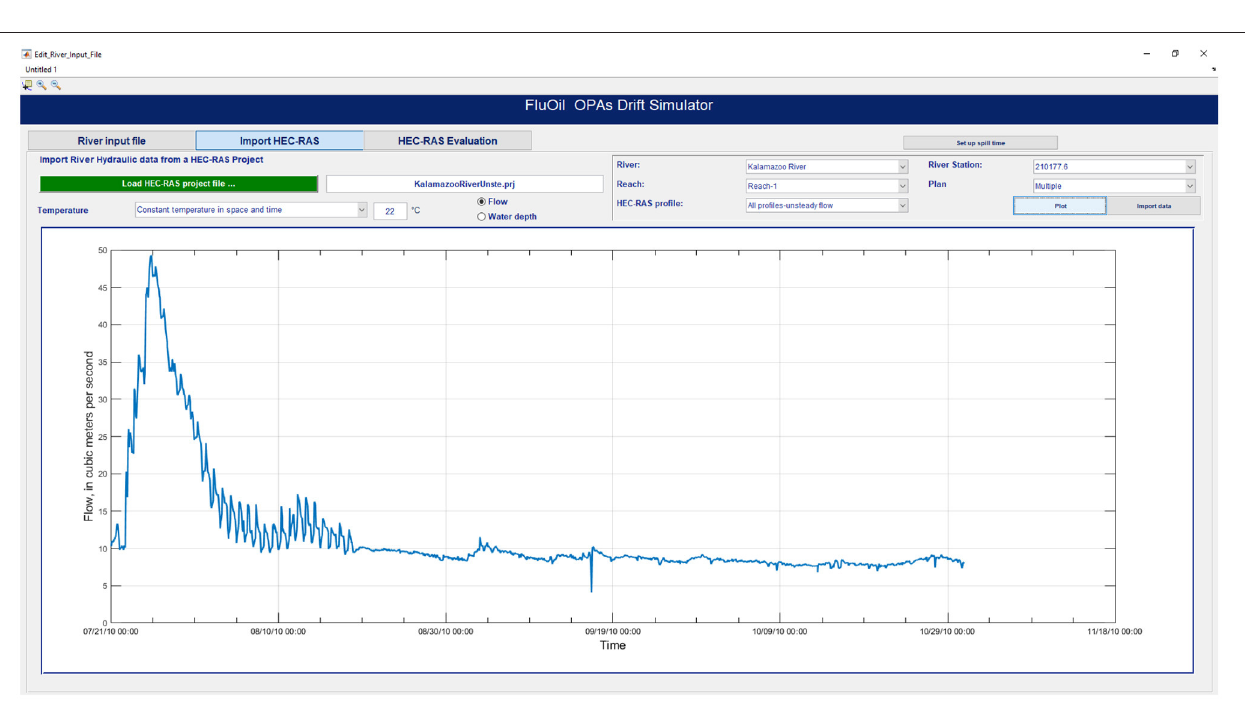
FIGURE 3 | Example of the FluOil GUI for importing hydraulic data from the unsteady one-dimensional Kalamazoo River HEC-RAS